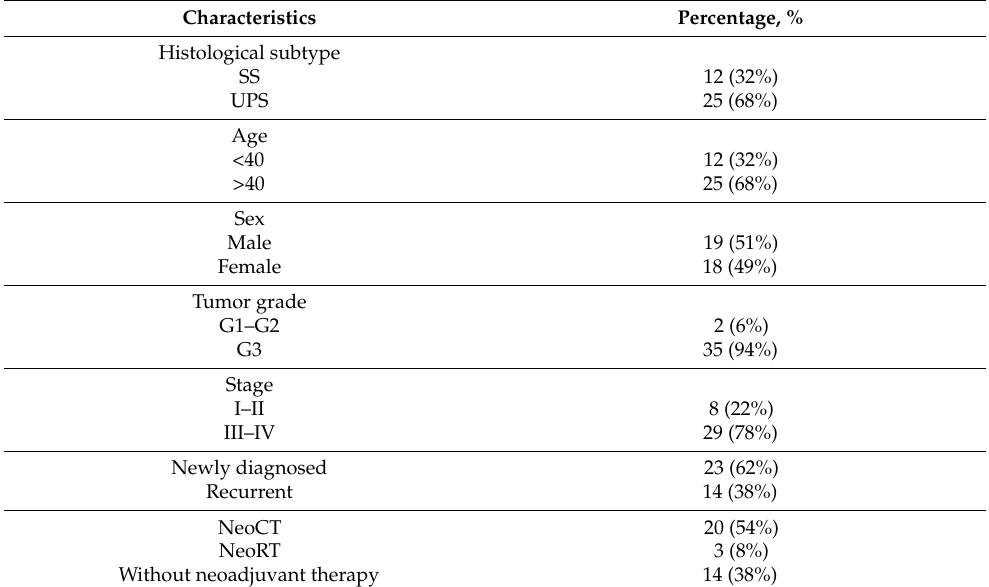
Table 2. Clinical characteristics of